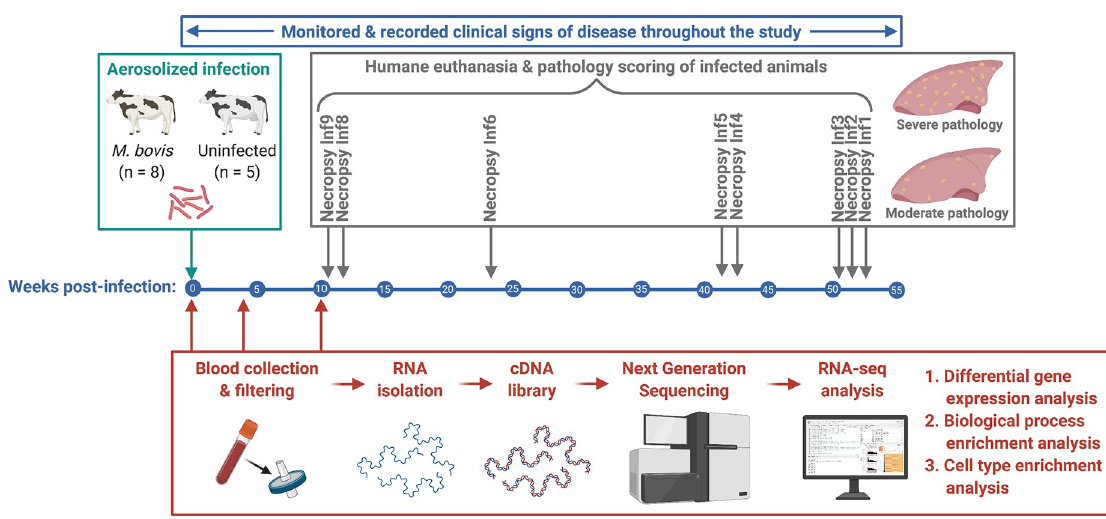
Fig 1. Overview of experimental timeline and workflow. Cattle were infected with M . bovis (n = 8) or left uninfected (n = 5). Following infection, whole blood was collected, clinical signs of disease were monitored, and pathology grading was assessed at necropsies. Whole blood was collected, and RNA was stored on filters from M . bovis -infected (n = 8) and uninfected (n = 5) cattle at 0 wpi, 4 wpi, and 10 wpi. RNA was later isolated and processed to create cDNA libraries that were sequenced, and RNA-seq data were analyzed for differential gene expression, biological process enrichment, and cell type enrichment. Clinical signs of disease were assessed throughout the study, and animals were euthanized as signs of disease became evident. Immediately following euthanasia, necropsies were performed to assess severity of post-mortem